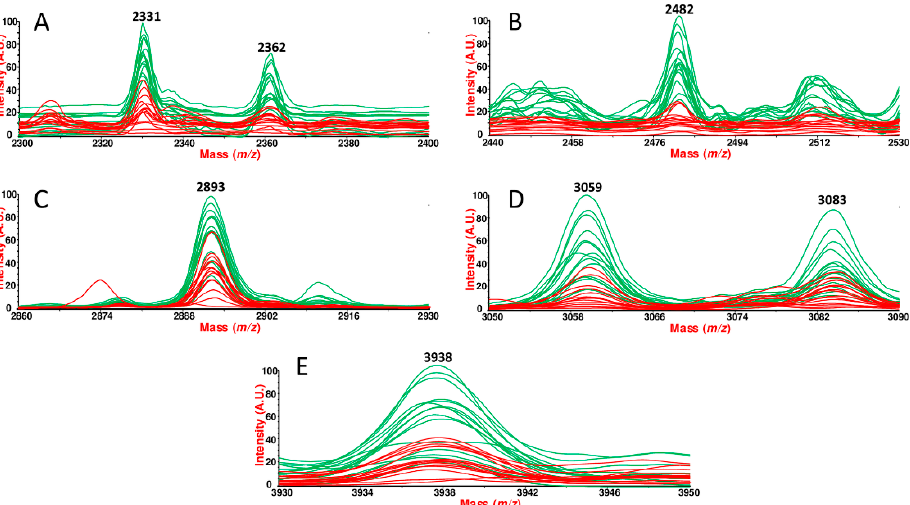
Figure 6. Traces overlay for discriminant peaks between fertile and infertile men. MALDI-TOF fingerprints comparison of SP samples between fertile (green) subjects and infertile (red) patients, obtained using Data Explorer software. Spectra overlay in absolute units highlights the peak intensity variation resulted statistically significant for the m / z peaks 2331 and 2362 ( A ), 2482 ( B ), 2893 ( C ), 3059 and 3083 ( D ), 3938 ( E ).